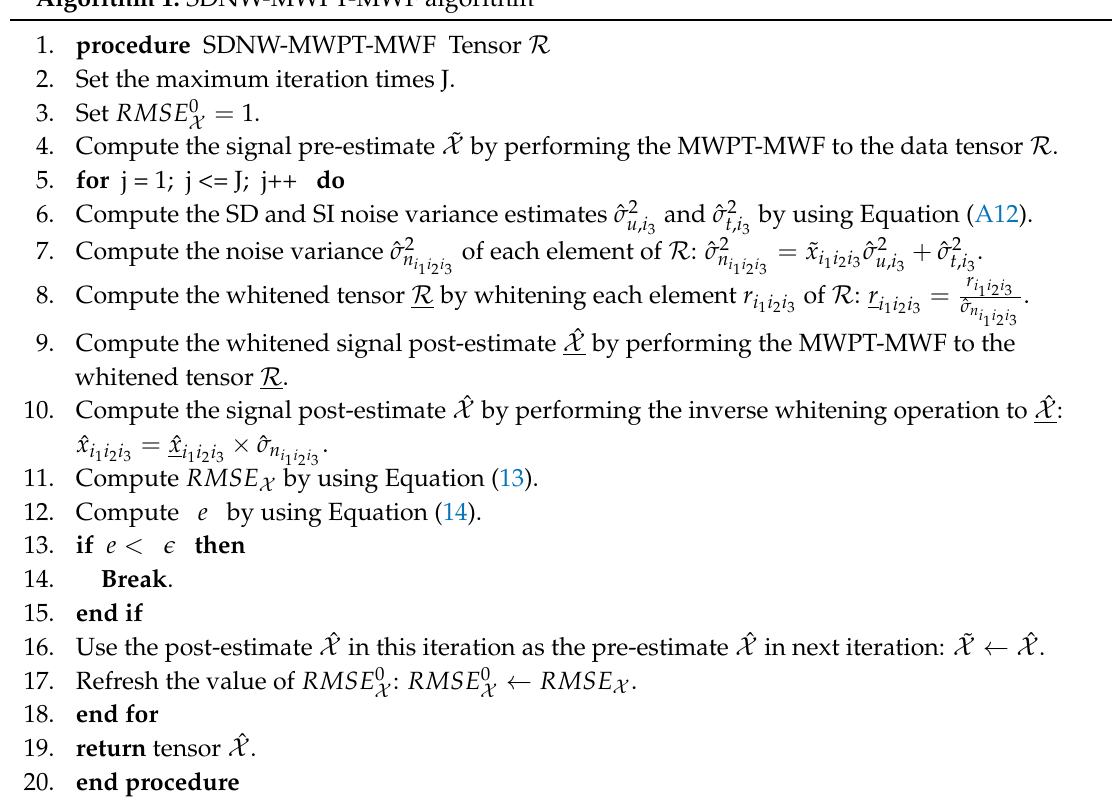
Algorithm 1: SDNW-MWPT-MWF